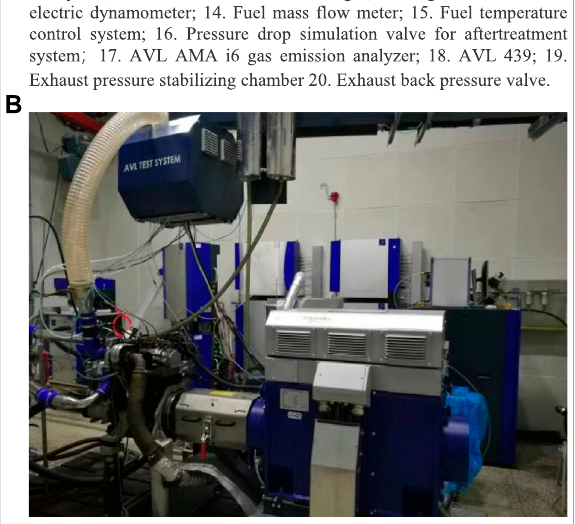
FIGURE 1 Test system for diesel engine at high altitudes. (A) Layout of test system, (B) Experiment test set